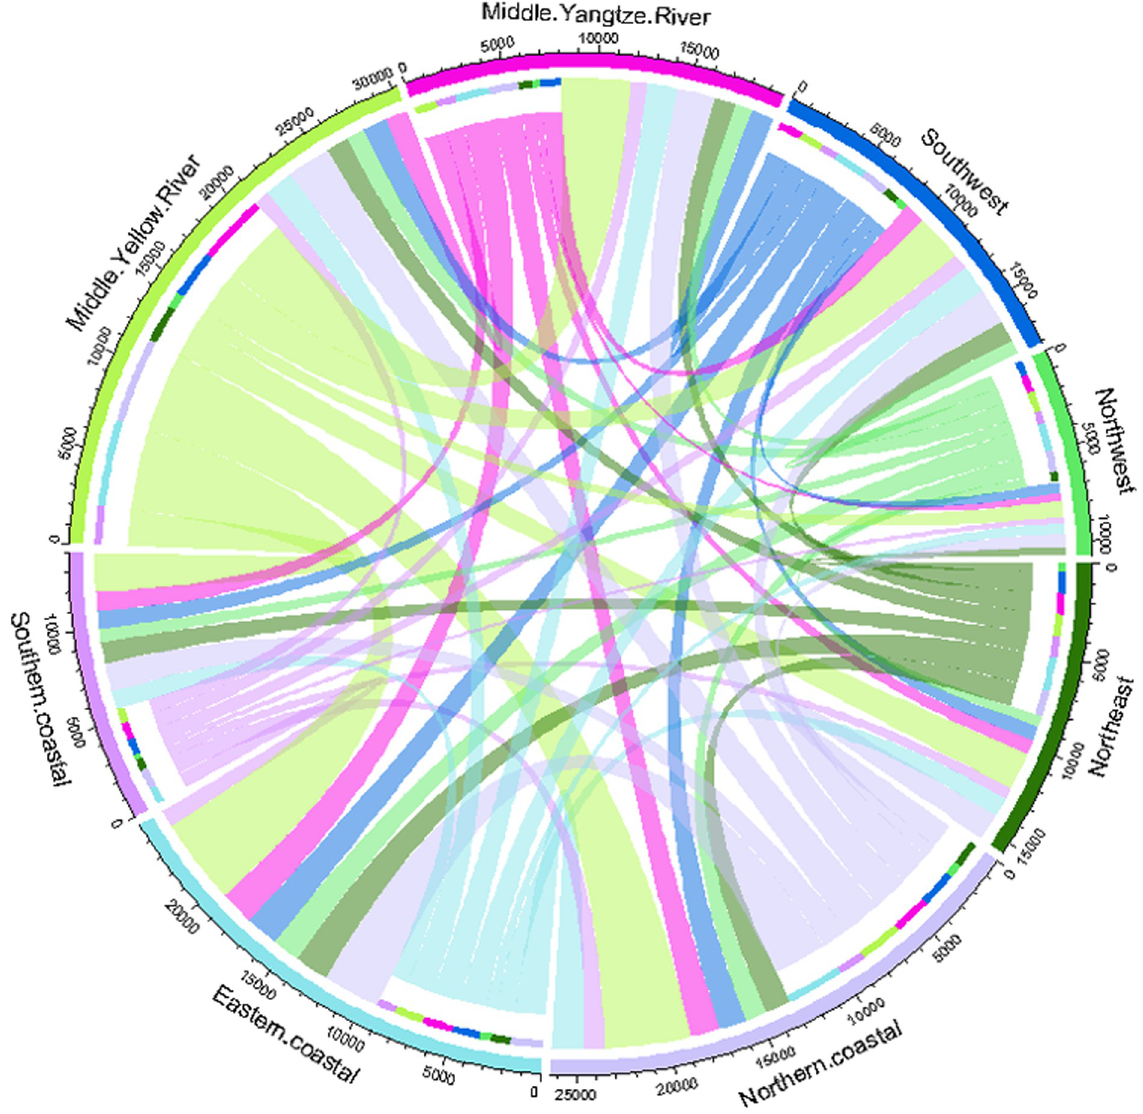
Fig 1. Embodied carbon trade among the eight regions in 2012 (unit: 10,000